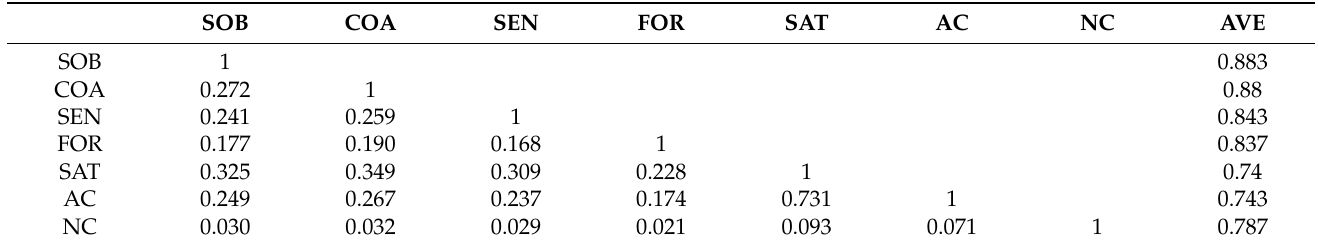
Table 4. Discriminant validity.